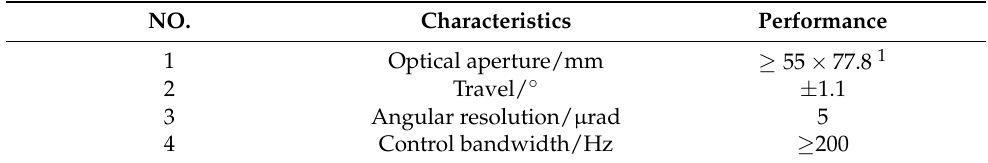
Table 2. Performing requirements of the FSM.